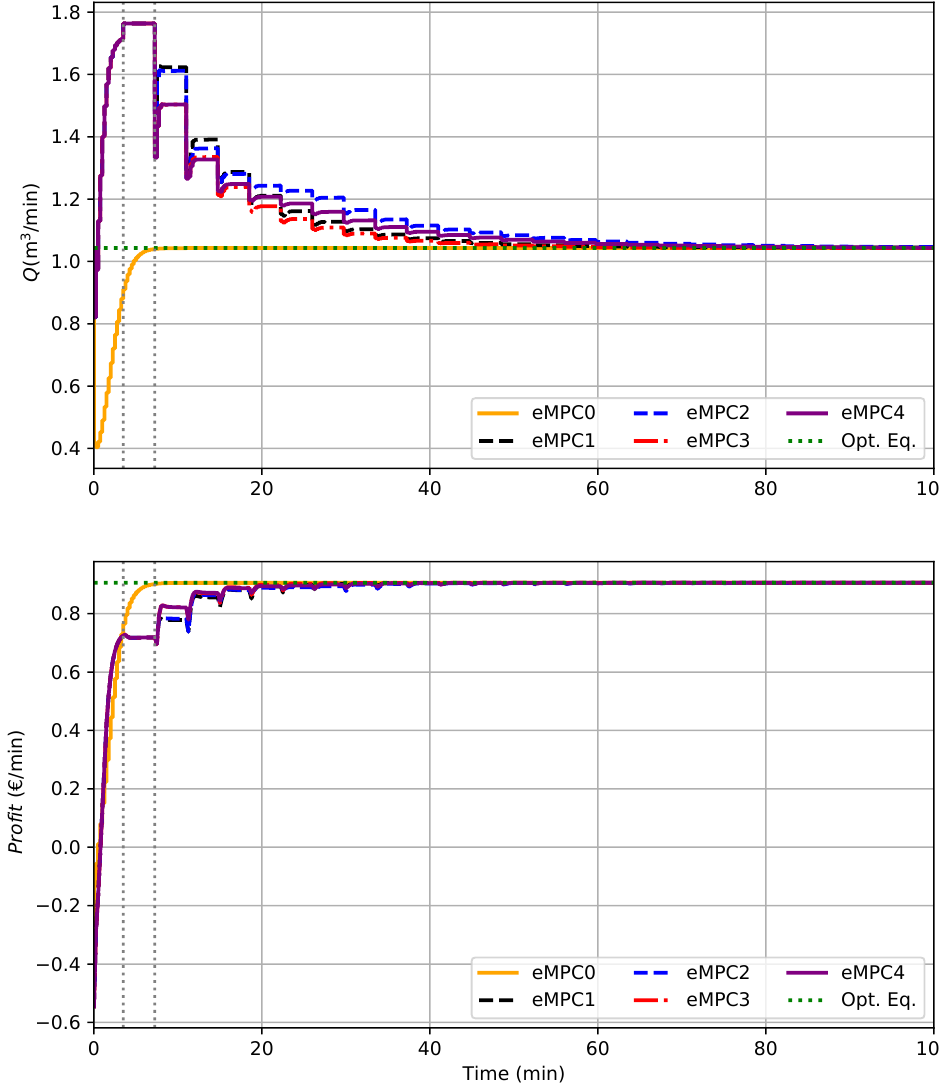
Figure 3. Reactor performance with five controllers and M = 15: input ( top ) and profit ( bottom ). The dotted vertical lines depict the time interval [3.75–7.5] min used for Λ